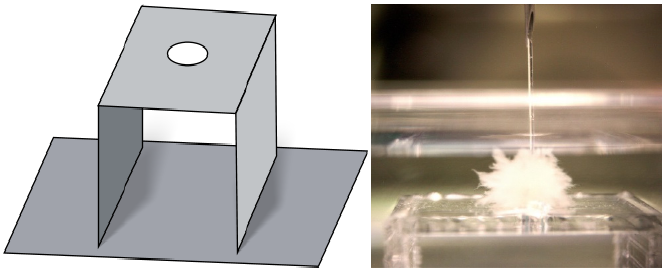
Figure 1. Holder for the measurement of the oxygen gradient in shiitake pellets.